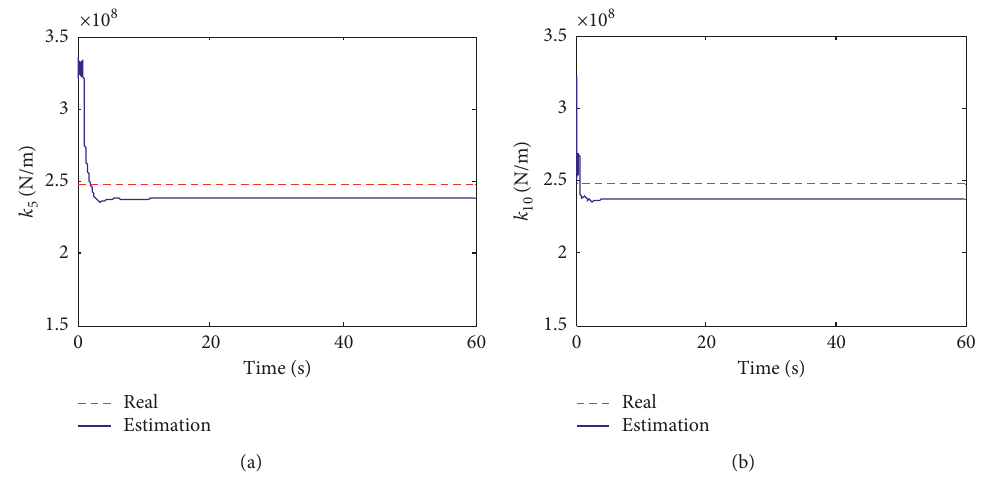
Figure 6: Estimation results of unknown stiffness coefficients on the (a) fifth floor and (b) tenth floor.